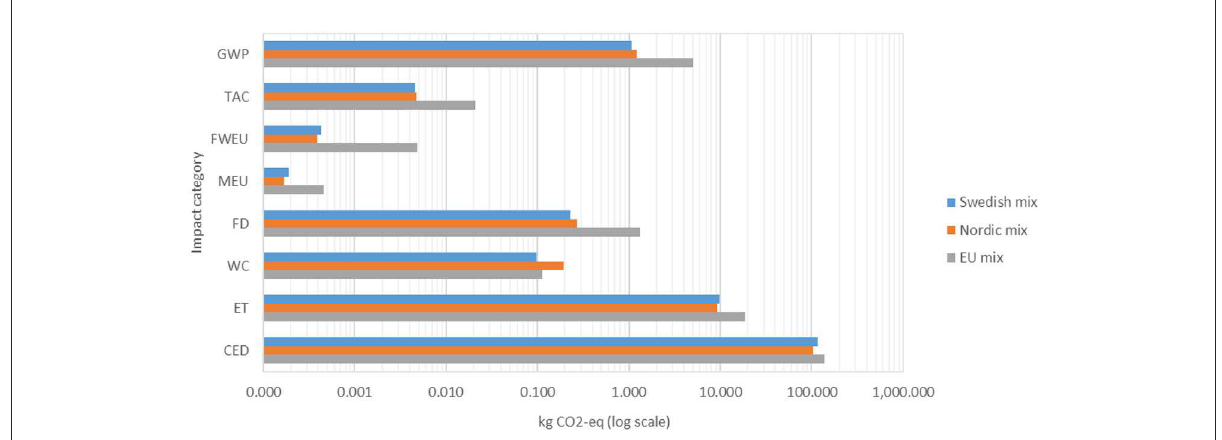
FIGURE4 The environmental impacts based on Swedish, Nordic, and European grid mixes (log scale).